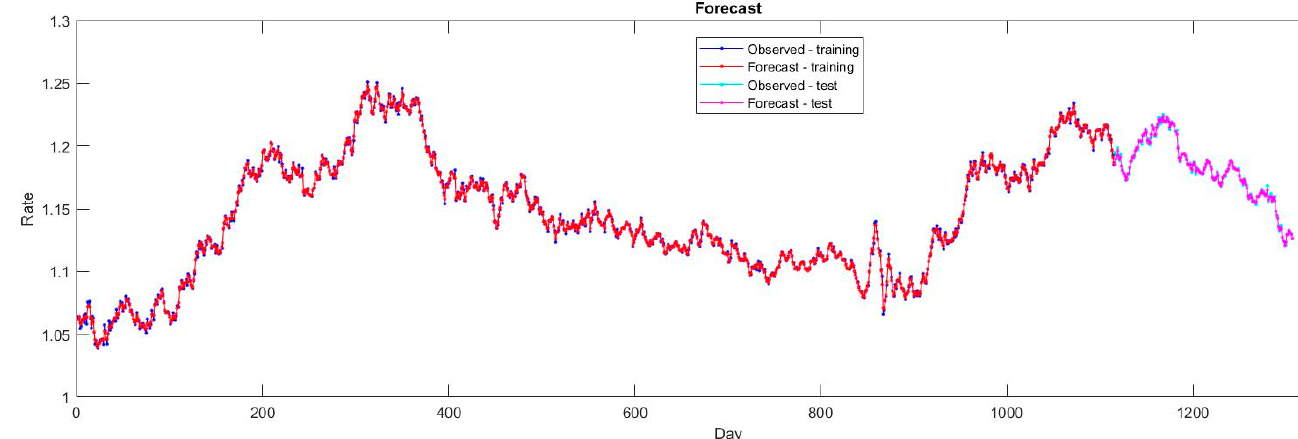
Figure 32. EUR–USD: LSTM–ADAM optimizer training.